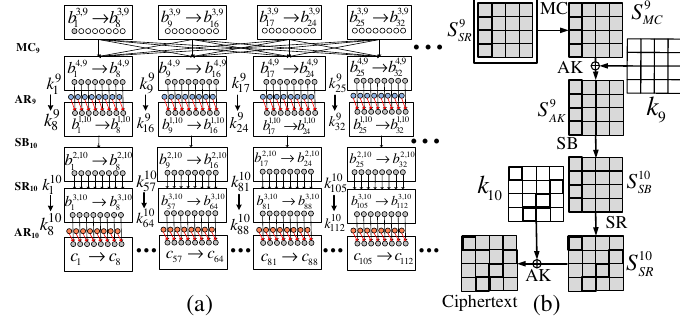
Figure 5: Example: Finding Key Parts for the Distinguisher Evaluations in